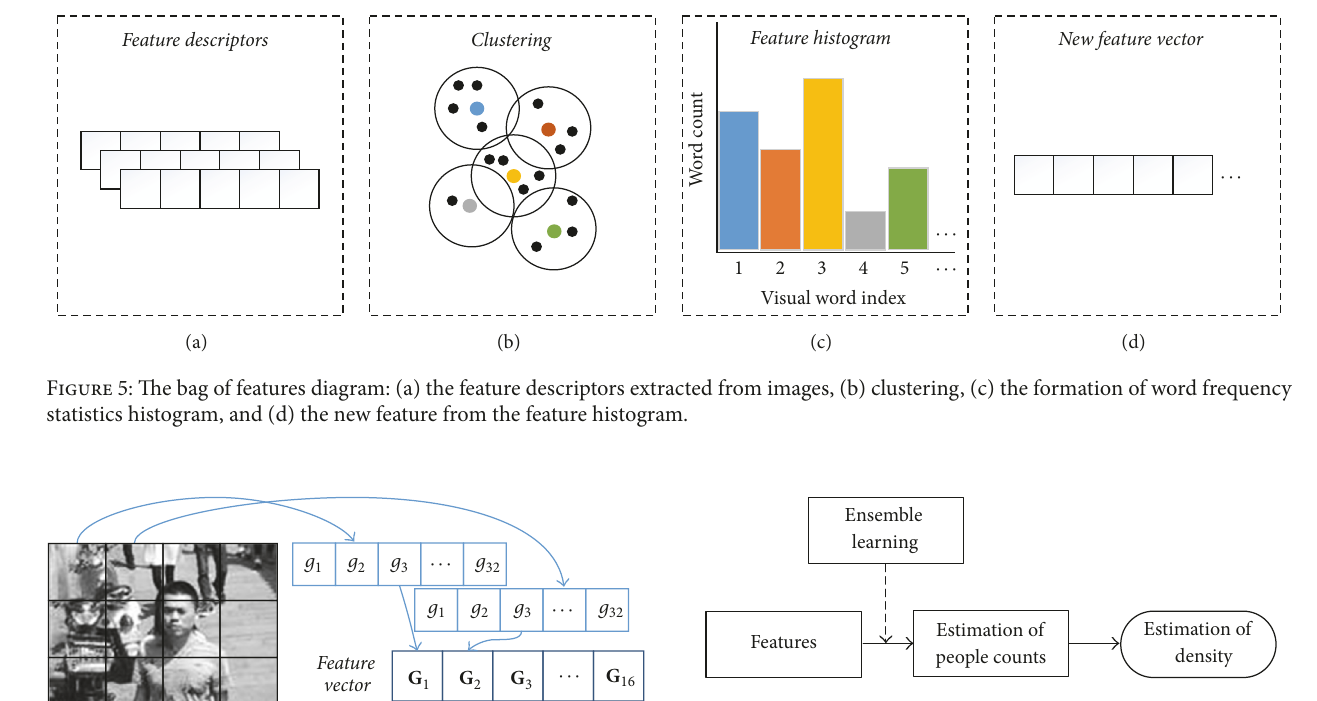
Figure 7: The process from features to density